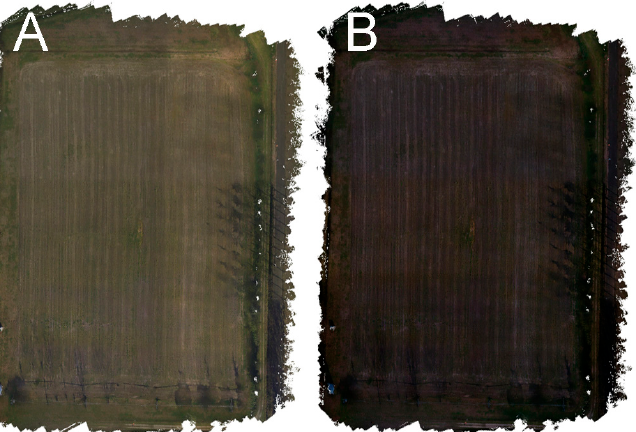
Figure 2. Examples of calibrated ( A ) and non-calibrated ( B ) orthophoto reconstructed randomly by combining the same six zones over the three days of the experiment.